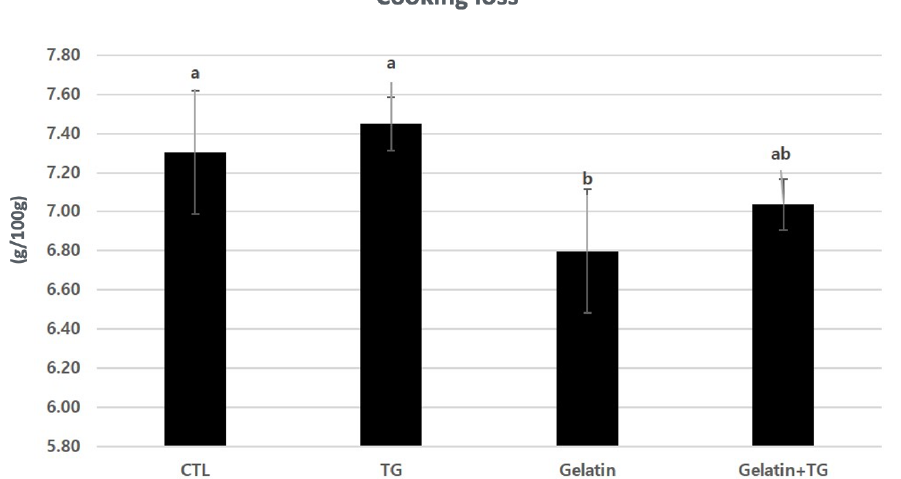
Figure 4. Cooking loss (g/100 g) of restructured ham with gelatin and transglutaminase. a,b Means ( n = 3) with the same superscripts in the same row are not different ( p > 0.05).